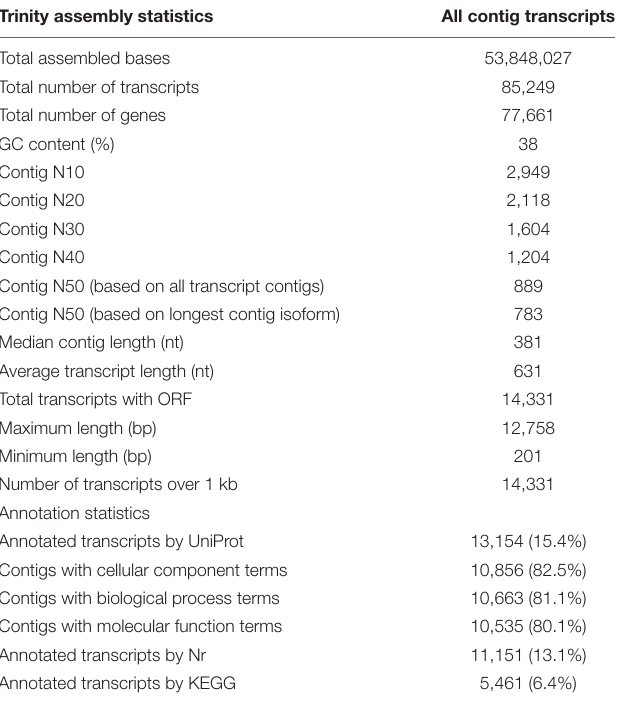
TABLE 2 | De novo assembly and annotation